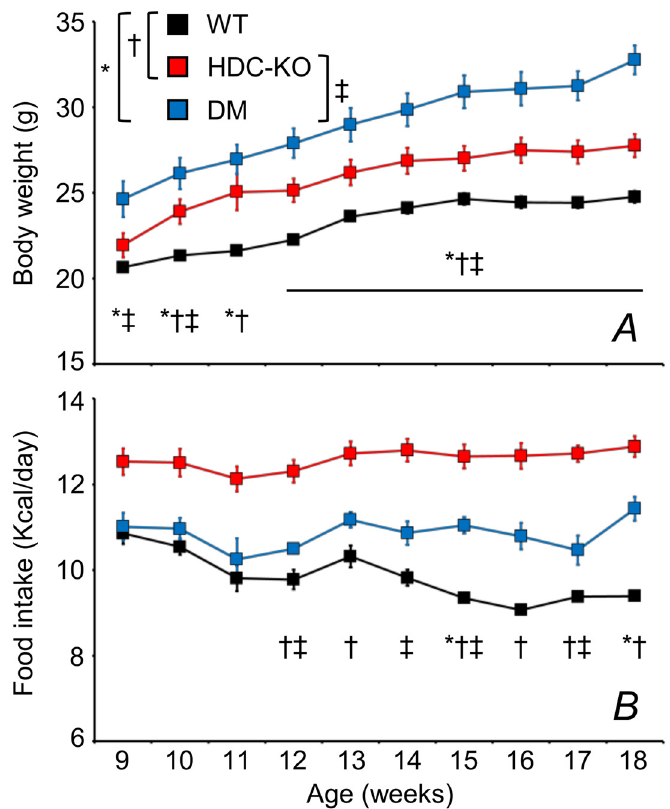
Fig 3. Body weight and caloric intake. Body weight (A) and nominal caloric food intake (B). Data are means ± SEM with n = 13 – 14 (WT), 10 – 14 (HDC-KO), and 3 – 8 (DM) at different time points. * , † , and ‡ , P < 0.05, WT vs. DM, WT vs. HDC-KO, and HDC-KO vs. DM, respectively (t-tests). Symbols indicating significant differences above horizontal lines apply to each time point above the line.